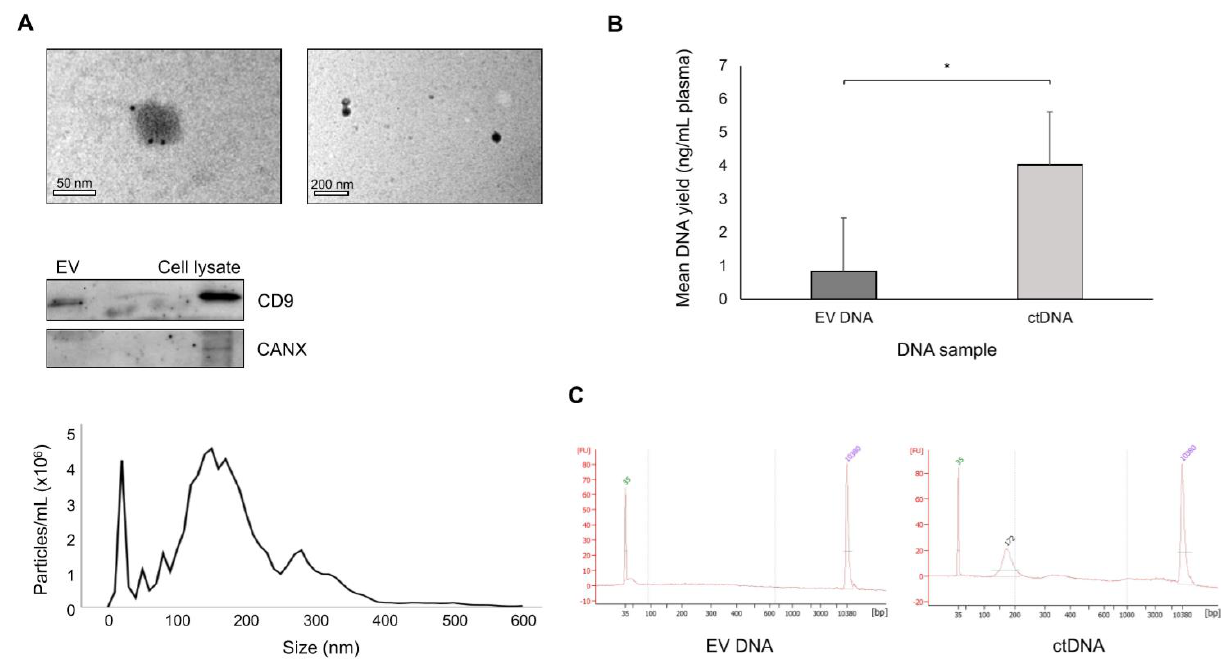
Figure 1. Validation of extracellular vesicle (EV) isolation and DNA extraction from plasma. ( A ) Electron micrographs (top) demonstrate successful isolation of particles approximately 50 nm in diameter with ultracentrifugation (left panel: 30,000× magnification of single EV; right panel: 8000× magnification of multiple EVs). Particles were positive for CD9 (black dots), as determined by staining of samples with gold-labelled antibodies specific for the CD9 protein. Western blotting of samples isolated with ultracentrifugation (EV; middle) confirmed the presence of CD9, as well as negativity for calnexin (CANX). A sample of cell lysate from breast cancer cell line MDA-MB-231 was used as a positive control. Nanoparticle tracking analysis (bottom) determined that particles isolated fell within the expected size range of 30–600 nm, with peaks at 30, 150 and 300 nm. ( B ) Mean ctDNA and EV DNA yields (ng/mL plasma) for patient A3 (* = p- value of 0.02). ( C ) Representative electropherograms of ctDNA (left) and EV DNA (right) showing the fragment size distribution profiles (bp) in relative fluorescence units (FU). Lower marker = 35 bp; upper marker = 10,380 bp. Dotted lines define regions of interest. Green lines indicate peak size region.